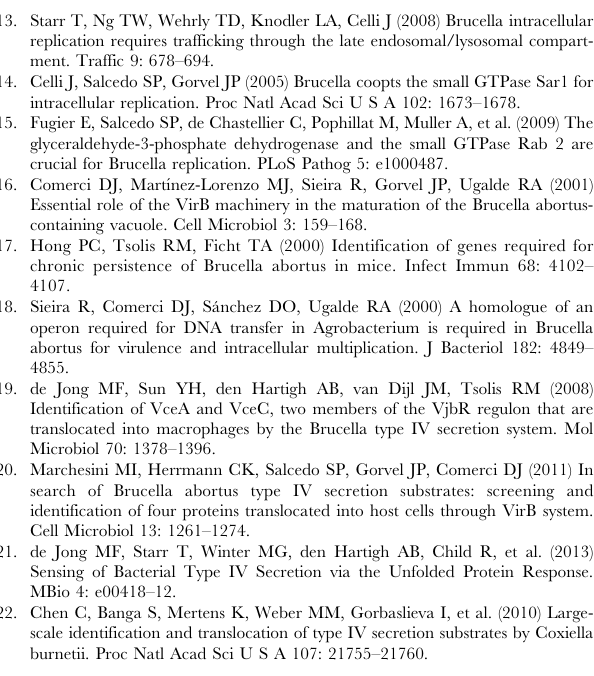
Insets in micrographs of GFP-BspA-expressing cells show accumulation of GFP-BspA in ERGIC structures (arrows) in addition to the ER. Scale bars, 10, 2 m m. Figure S6 Confirmation of in-frame deletion of bsp genes in B. abortus strain 2308. (A and B) Chromosomal loci flanking the deleted bsp genes were amplified by PCR using primers described in Table S3 and resolved by electrophoresis. Figure S7 Brucella infection does not affect the kinetics of Golgi re- assembly after BFA washout. HeLa cells either transfected with pSEAP-2 alone or infected with B. abortus strain 2308 or infected and transfected with pSEAP-2 were incubated with 5 m g/ml Brefeldin A (BFA) for 30 min, and then washed extensively. Cells were then fixed and immunostained for the Golgi apparatus using anti-GM130 antibodies, and changes in GM130 localization were monitored at the indicated times after BFA washout. Scale bar, 10 m m. Figure S8 Representative expression of 3 6 FLAG-tagged Bsp proteins in B. abortus 2308. Whole cell lysates from strains carrying derivatives of either pJC123 or pJC124 expressing 3 6 FLAG- tagged BspA, BspB, BspF, BspD and BspE were resolved by SDS- PAGE and analyzed by Western blotting using either an anti- FLAG antibody to detect Bsp protein expression, or a anti- Brucella p17 protein to verify equal loading of samples. Asterisks indicate full length proteins. Figure S9 Effect of VirB T4SS deficiency on infection and persistence of Brucella in mice. Groups of five 6–8 weeks old BALB/c female mice were infected intraperitoneally (i.p.) with approximately 5 6 10 4 CFUs of B. abortus strain 2308 and its isogenic D virB9 mutant strain. On day 3, 7 and 42 mice were euthanized, and splenomegaly (A) and bacterial loads in spleens (B) and livers (C) were examined.